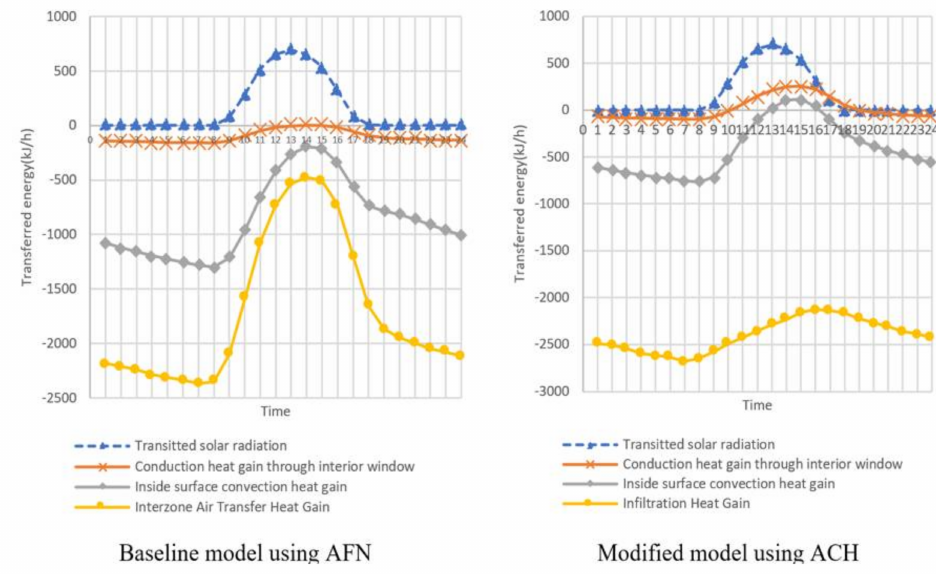
Figure 5. Types of heat transfer on heating design day.